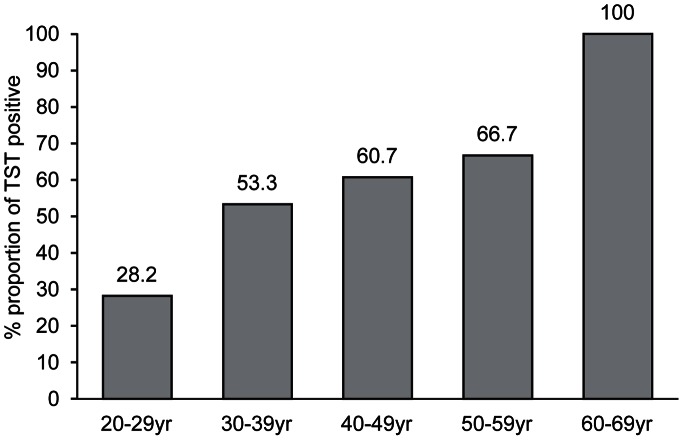
Trend of TST positivity according to age.